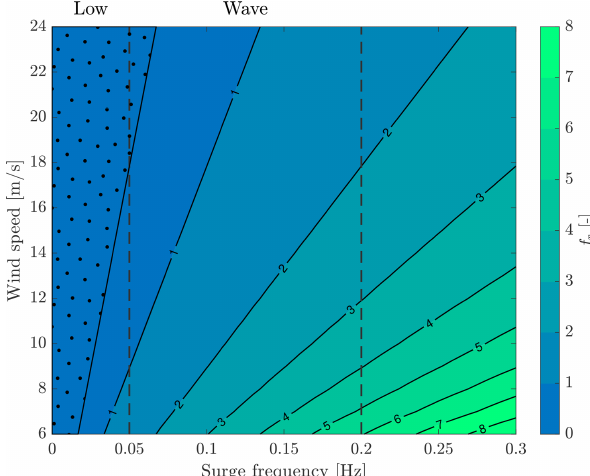
Figure A1. Reduced frequency f r as a function of surge motion frequency and wind speed for a 10MW floating turbine (rotor di- ameter 178m). The vertical dashed lines mark the low frequency range (0–0.05Hz) and the wave frequency range (0.05–0.2Hz). Re- duced frequency is lower than 0.5 in the dotted